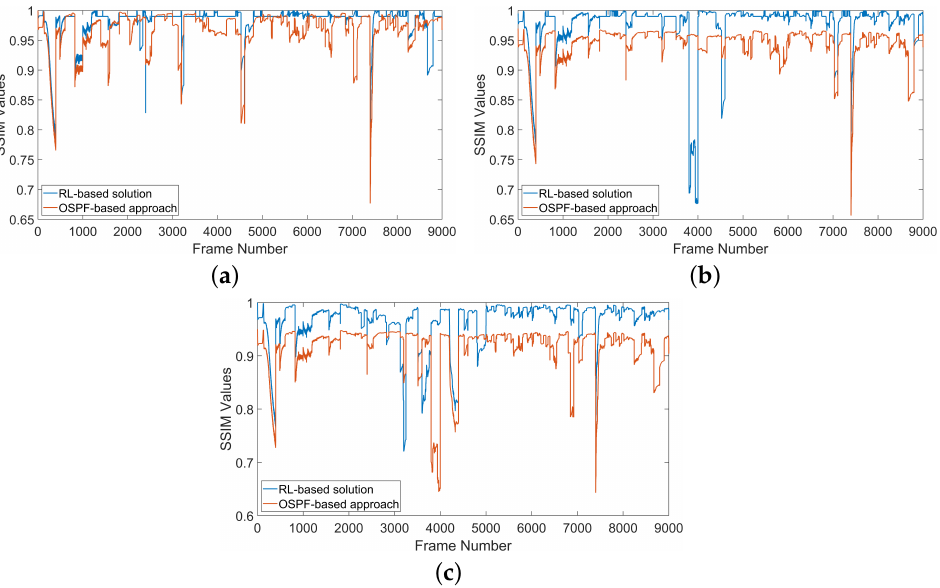
Figure 4. SSIM values for DASH video under low traffic loads in three different topologies. ( a ) Abi- lene; ( b ) Geant; ( c ) Cernet.